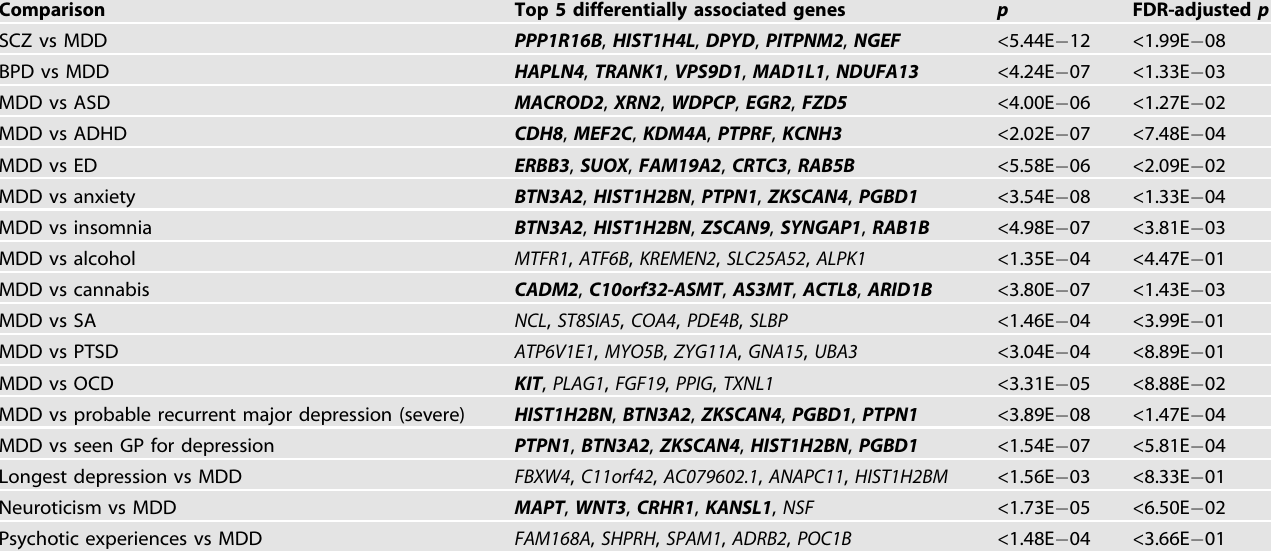
Table 4. Top fi ve differentially associated genes from each comparison based on gene-based analysis using MAGMA (listing comparisons involving